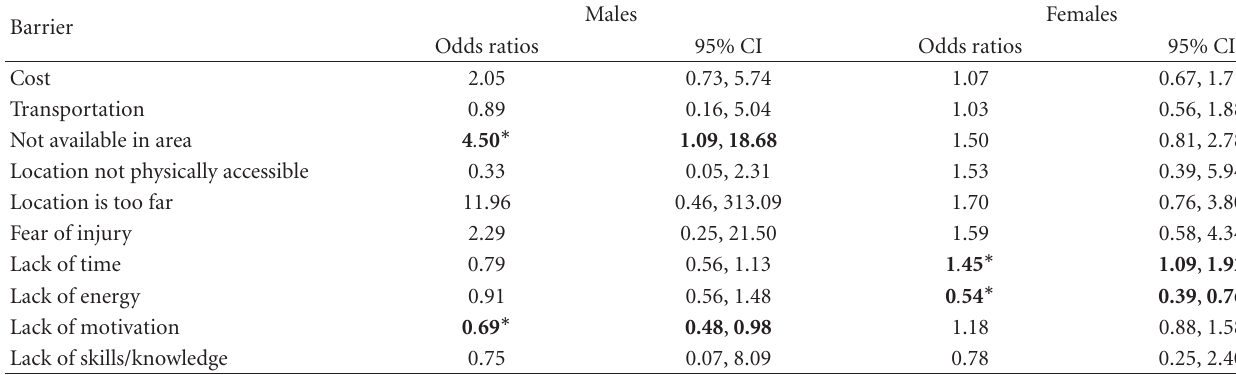
Table 3: Odds of nonparticipation as a function of type of barrier.